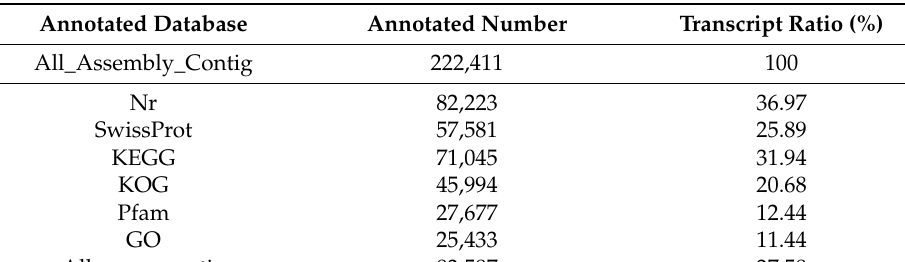
Table 3. Statistics of function annotation.